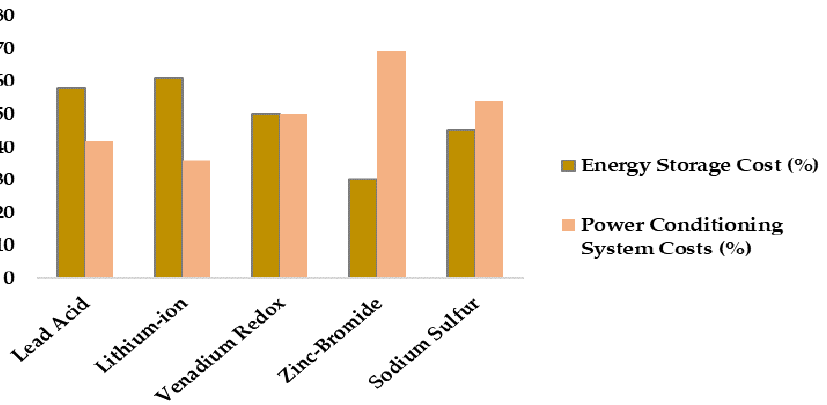
Figure 13. Power-conditioning system costs.